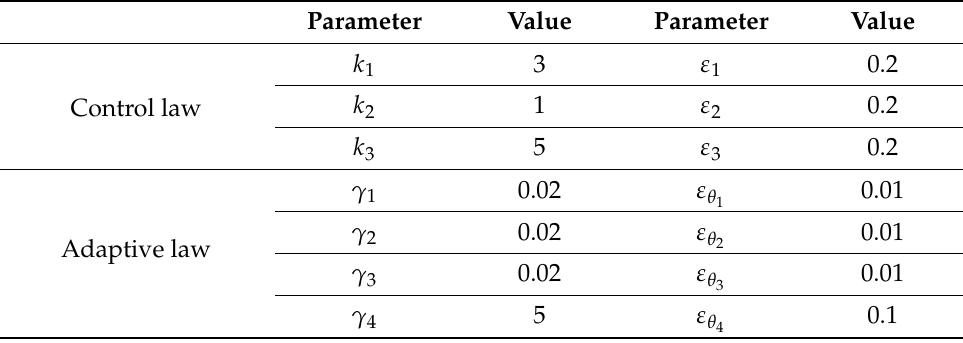
Table 4. The parameter settings of the control